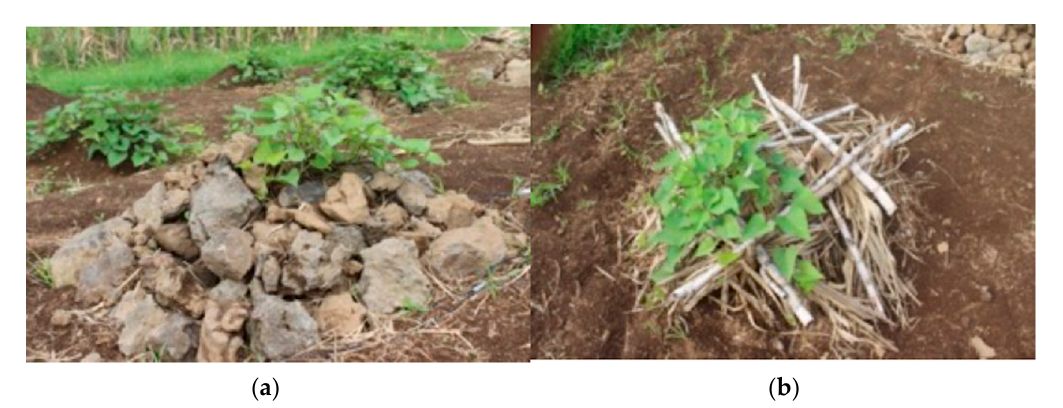
Figure 2. Examples of rock mulch ( a ) and sugar cane mulch ( b )